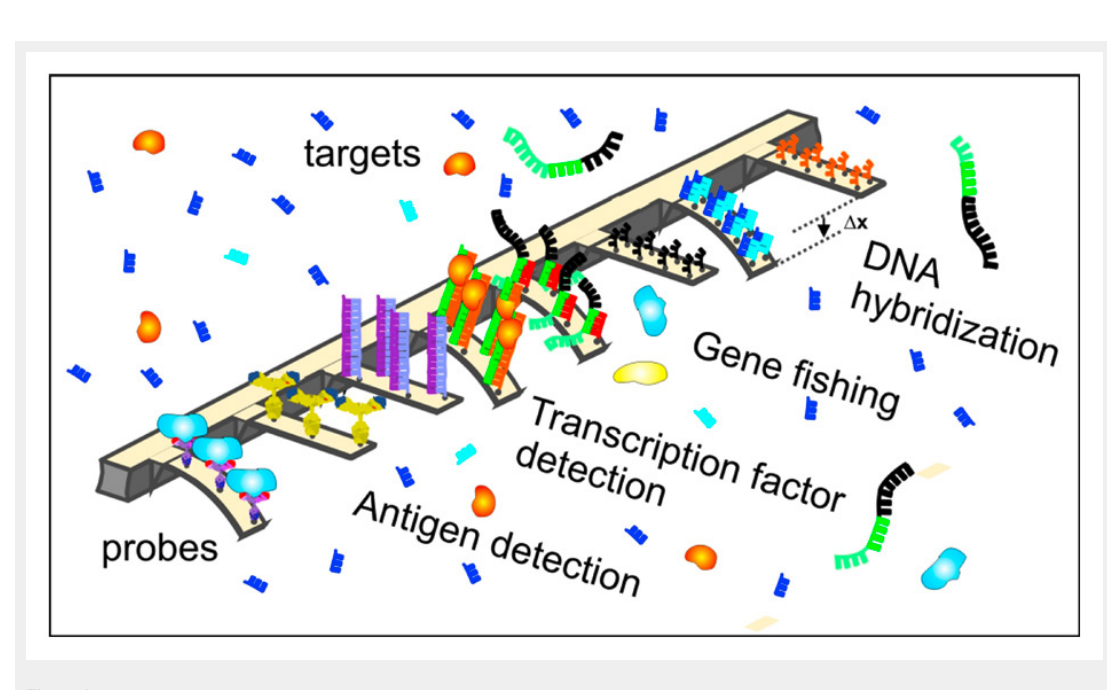
This figure illustrates a future application for cantilever arrays, where cantilevers in a single array are functionalised with a variety of biomolecules, ranging from antibodies to double strand DNA to single strand DNA. In such a configuration, it will be possible to investigate multiple markers with one cantilever